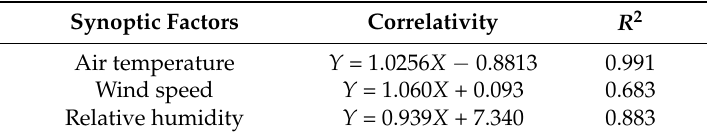
Table 6. Correlativity between synoptic data at Ejina station and EJL station.